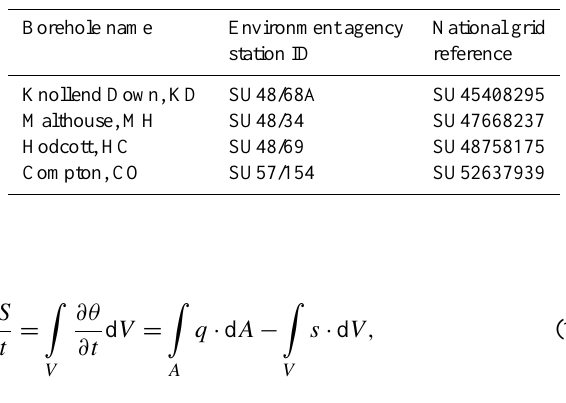
Table 1. Borehole